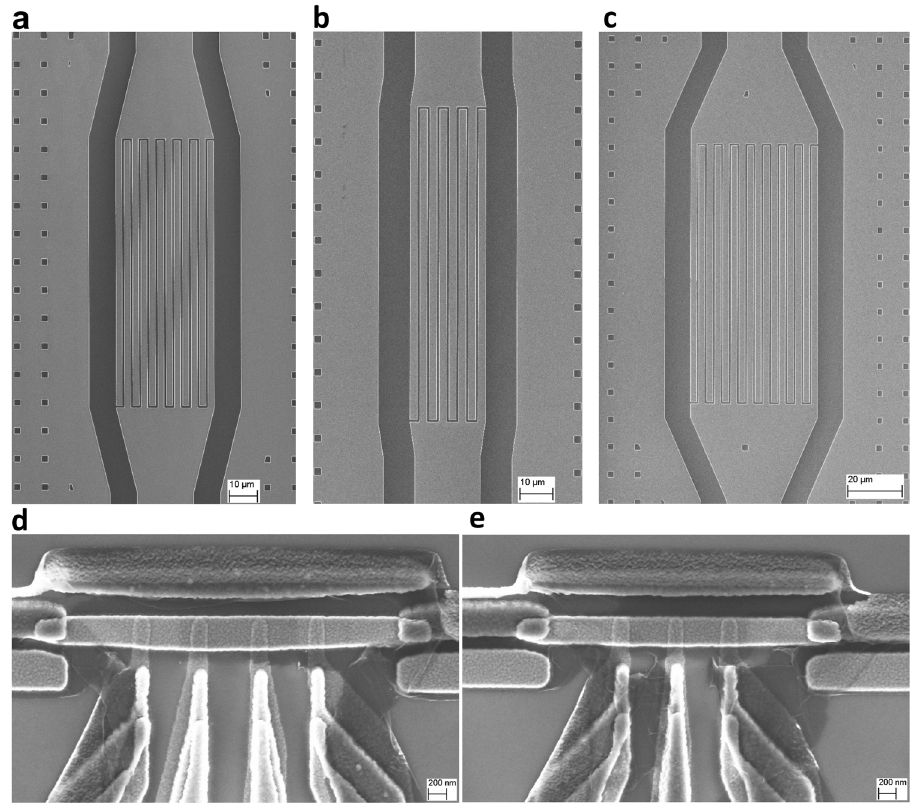
Fig. 3 Scanning electron micrograph of capacitors and copper resistors. Scanning electron micrograph of the capacitors between resonators and right resistor C 0 R ¼ 48 fF ( a ) (scale bar: 10 μ m), hot resistor C 0 h ¼ 30 fF ( b ) (scale bar: 10 μ m), and left resistor C 0 L ¼ 70 fF ( c ) (scale bar: 20 μ m). The indicated capacitance values are obtained from COMSOL simulations. d Hot resistor R h = 5 Ω ( d ) (scale bar: 200 μ m). e Left and right resistors have the same design and nominal values R L = R R = 4 Ω ( e ) (scale bar: 200 μ